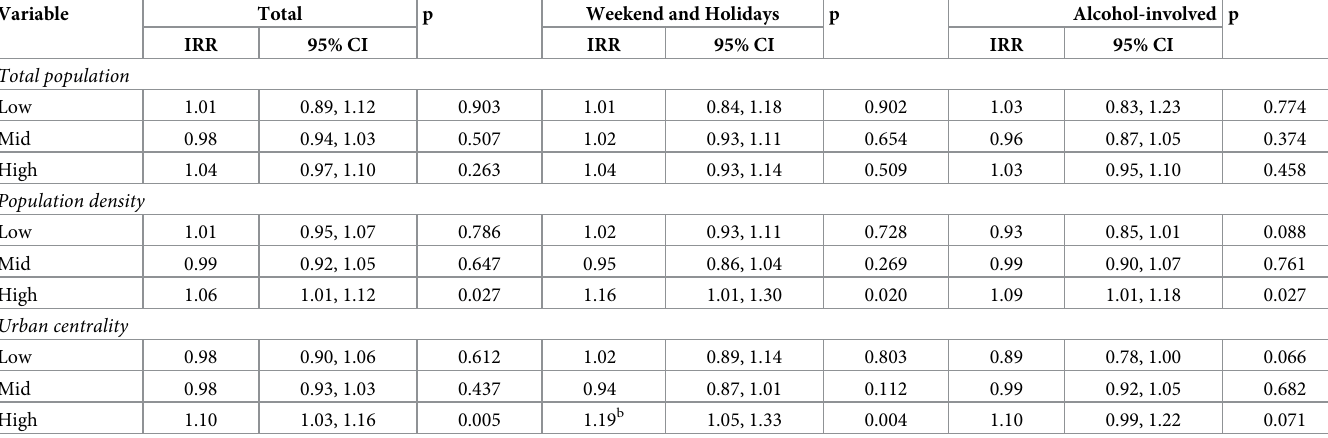
Table 3. Incidence rate ratios for the association of uber availability and total, weekend- and holiday-specific, and alcohol–involved related traffic fatalities by total population, population density, and urban centrality, principal counties of the largest 100 US metropolitan areas, 2009–2017 a .